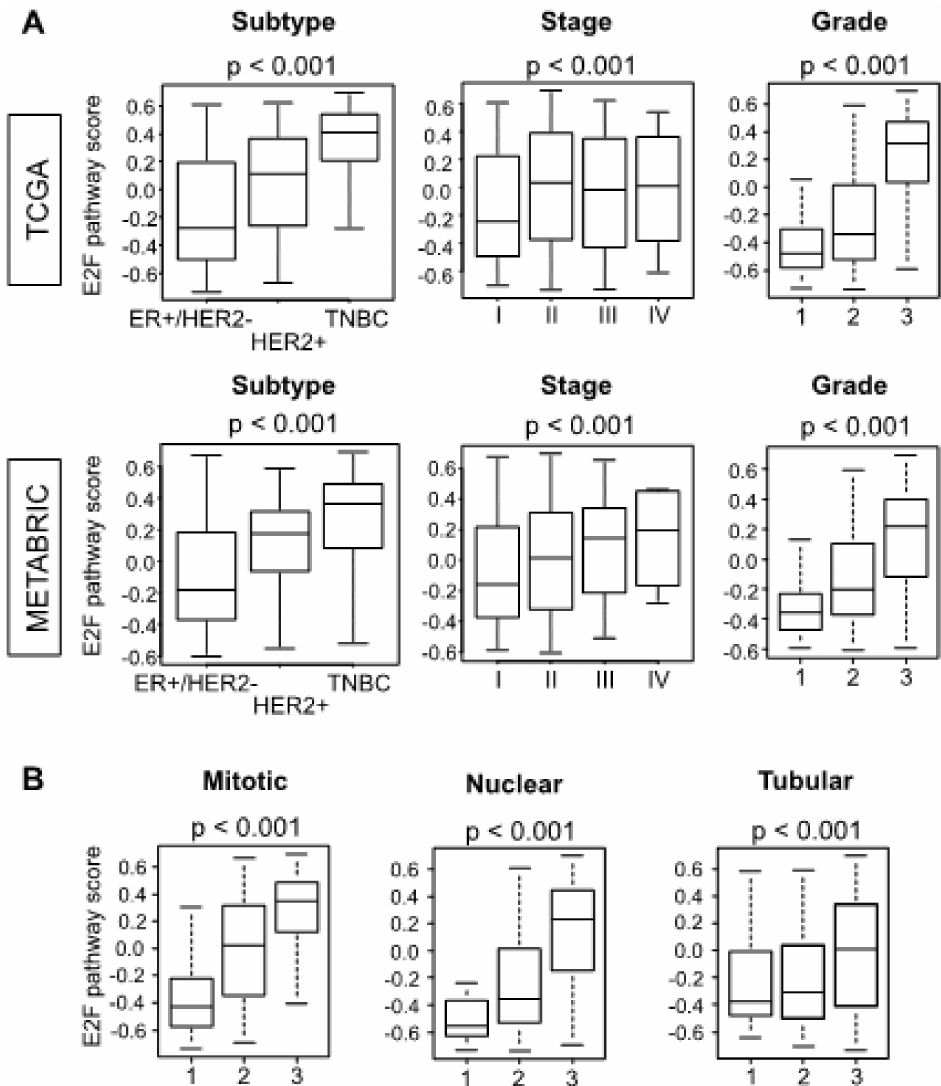
Figure 2. Tumors with a high E2F pathway score are more aggressive. ( A ) Boxplots of the E2F scores of tumors of di ff erent subtype, American Joint Committee on Cancer pathological stage, and Nottingham histological grade are shown for the TCGA and METABRIC cohorts. ( B ) E2F scores among TCGA tumors of di ff erent mitotic, nuclear, and tubular Nottingham sub-scores. All boxplots are of Tukey type, and depicted p values were calculated by ANOVA